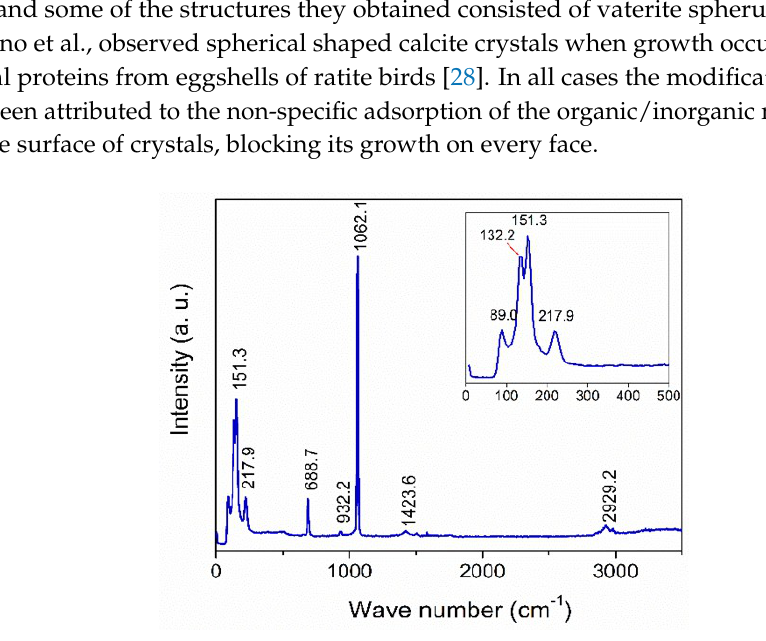
Figure 4. Raman spectrum of a Ba-synthetized biomorph in the gas diffusion method with pyruvic acid [0.1 M].